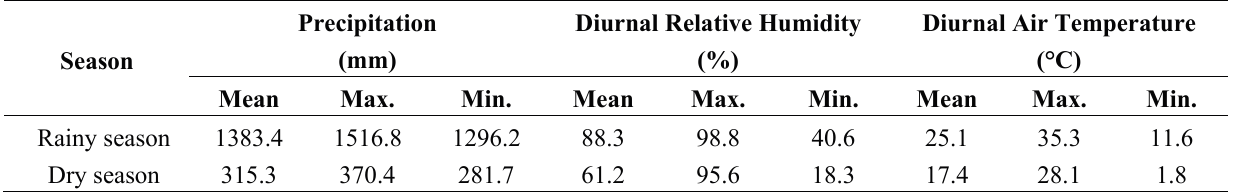
Table 4. Meteorological data for Dafushan forest park from 2008 to 2013 [26].